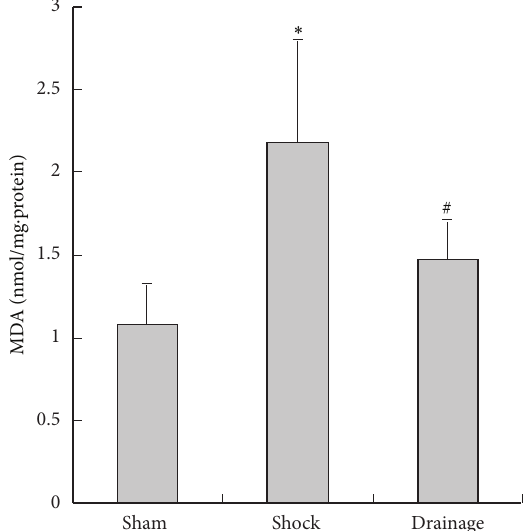
Figure 6: Effects of mesenteric lymph drainage on MDA content of renal homogenate in hemorrhagic shock rats without resuscitation (nmol/mg ⋅ protein, mean ± SD, 𝑛 = 6 ). ∗ 𝑃 < 0.05 versus sham group; # 𝑃 < 0.05 versus shock